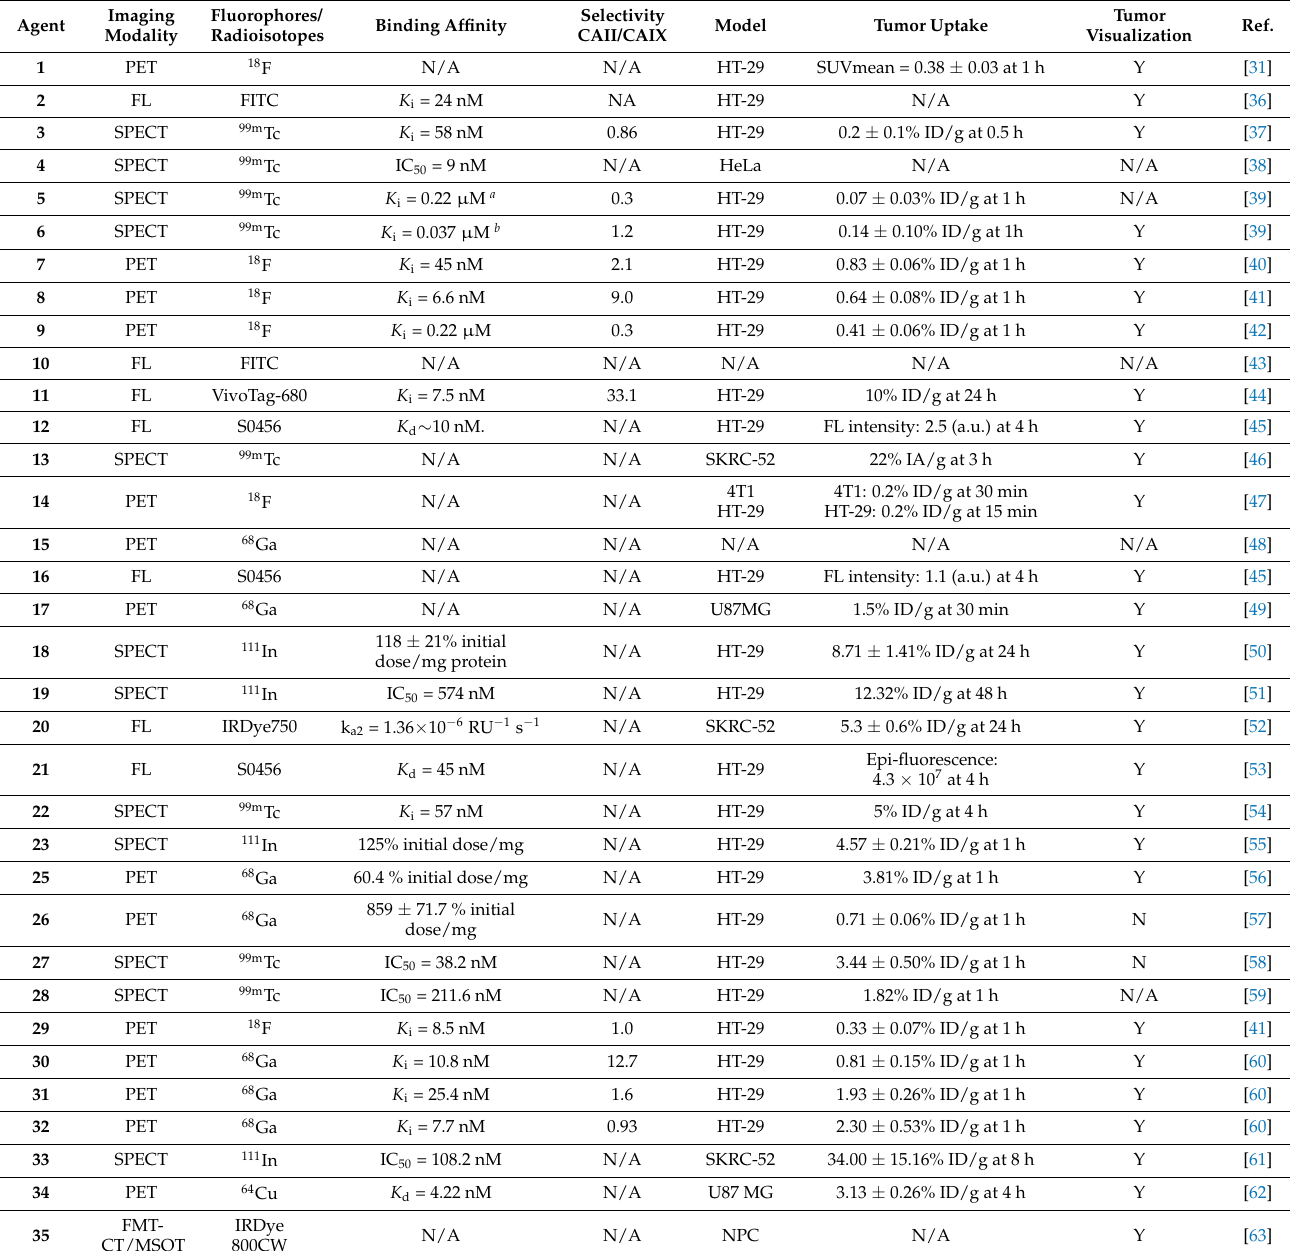
Table 2. Overview of preclinical evaluation of small-molecule-based CAIX-targeted probes.